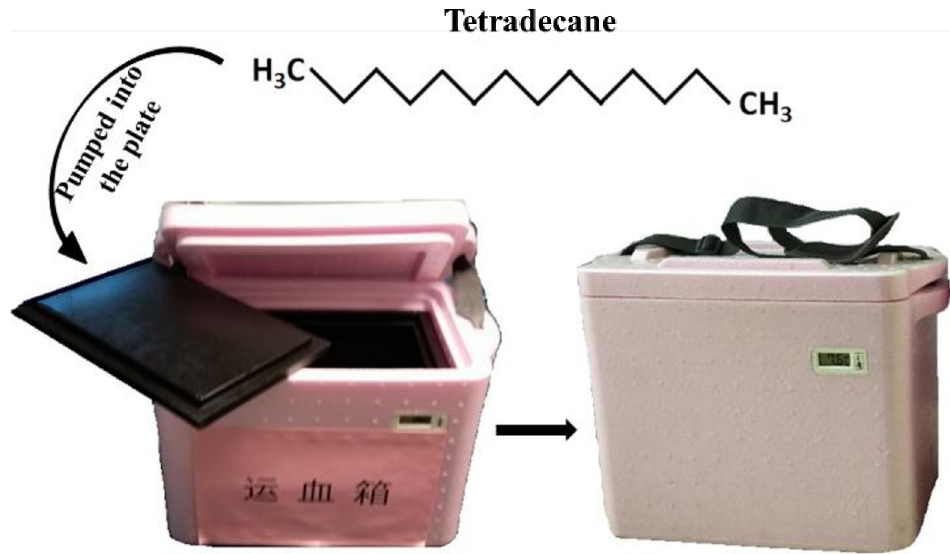
Fig 1. The structure and appearance of phase-change material blood containers.